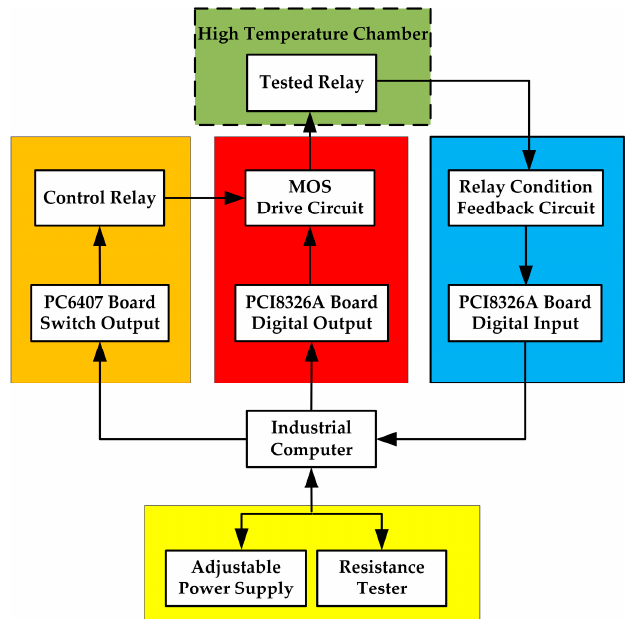
Figure 3. Test platform structure.